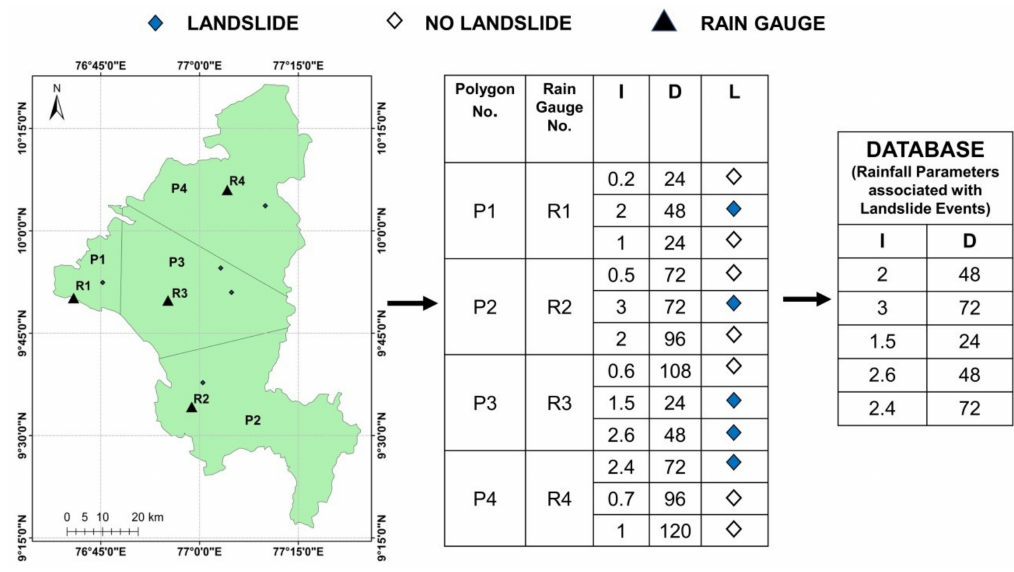
Figure 6. Conceptual sketch showing development of dataset: P1, P2, P3, and P4 represent the four Polygons and R1, R2, R3, and R4 are the reference rain gauges in each polygon. D = Duration of rainfall (hours); I = Intensity of rainfall (mmh − 1 ); L = Occurrence of landslide (Modified after